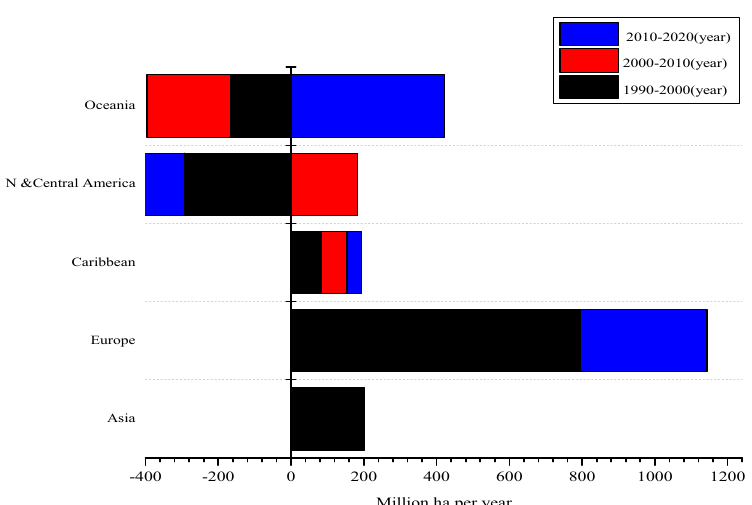
Figure 2. The overall net annual change in the area of forests by region 1999–2000, Source: (FAO, 2020).